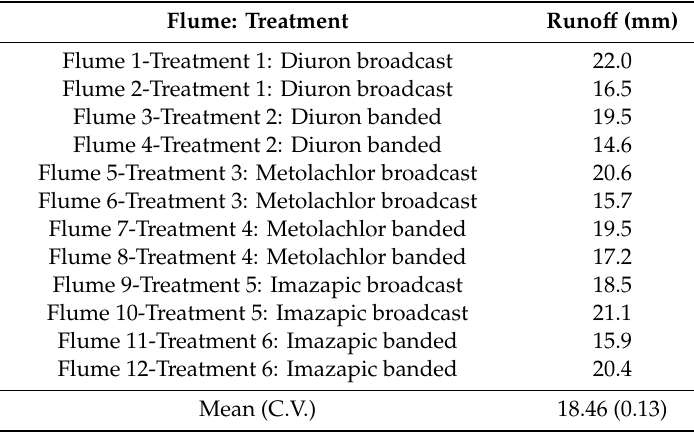
Table 3. Total runo ff volumes from each treatment